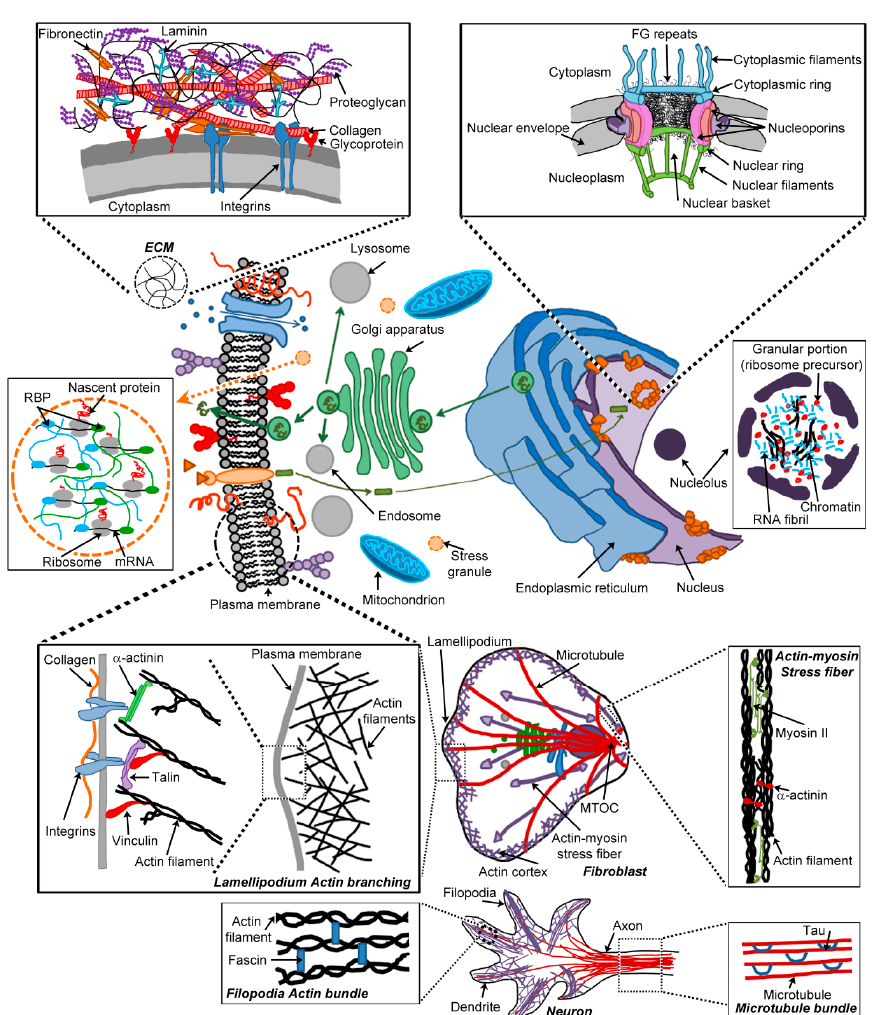
Figure 2. Cellular hydrogels. Hydrogel-forming polypeptides can be found either within the eukaryotic cell (e.g., membrane-less organelles such as the nucleolus and stress granules, the central channel of the nuclear pore complexes (NPC), and the cytoskeleton) or in the extracellular space (extracellular matrix (ECM)). Hydrogel-forming polypeptides provide a wide range of functions for eukaryotic cells: selective diffusion barriers (ECM and NPC), compartmentalisation (nucleolus and stress granules), physical integrity (NPC, ECM and cytoskeleton), and motility (ECM and cytoskeleton). Some cellular hydrogels are formed by ‘functional’ amyloid-forming polypeptides (e.g., the central channel of the NPC and stress granules), but others (nucleolus, ECM and cytoskeleton) derive from non-amyloid polypeptides. For each cellular hydrogel, the hydrogel-forming polypeptide, cross-linkers and any other molecules involved in hydrogelation are depicted. Molecules that are involved in triggering polymerisation and/or polymerisation control, but not in hydrogelation, have been omitted. At the centre of the figure is a schematic of a typical eukaryotic cell, showing organelles and vesicular transport (green circles, containing proteins as green ‘lines’) between organelles of the endomembrane system: endoplasmic reticulum (light blue), Golgi apparatus (green), endosome (grey), lysosome (grey) and plasma membrane. Molecules present at the plasma membrane are also depicted: proteins (red ‘lines’) and glycoproteins (red lines with circles); proteoglycans (purple circles); receptors (light orange), their ligands (dark orange triangles) and downstream effectors (green rectangle); and transmembrane channel (blue) with molecules able to cross through it (blue circles). The ECM ( top left inset )